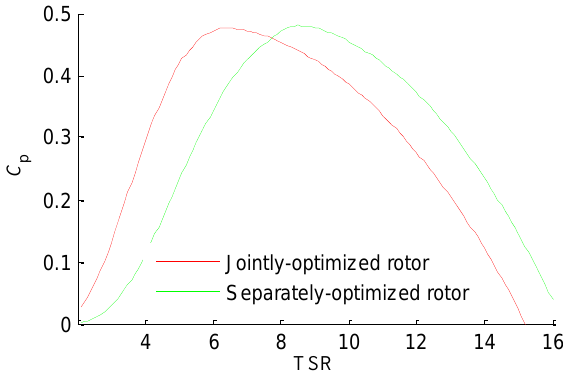
Figure 9. Power coefficient versus TSR curves of the optimized rotors.